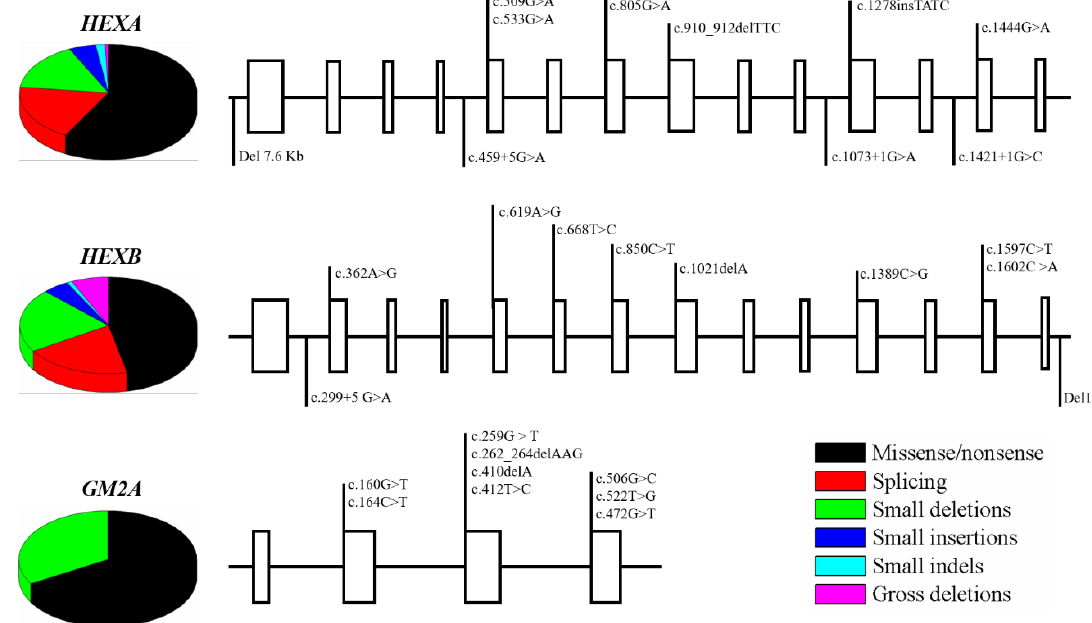
Figure 3. Common mutations on HEXA , HEXB , and GM2A genes . The figure shows some of the most common mutations identified on HEXA , HEXB , and GM2A , as well as their distribution throughout the gene. Mutations can be found either on exons (boxes), introns, and the 5′ and 3′UTRs. 14 exons and 13 introns are represented to HEXA and HEXB , whereas 4 exons and 3 introns are shown for GM2A . This figure was made according to the reviewed in [49–55].